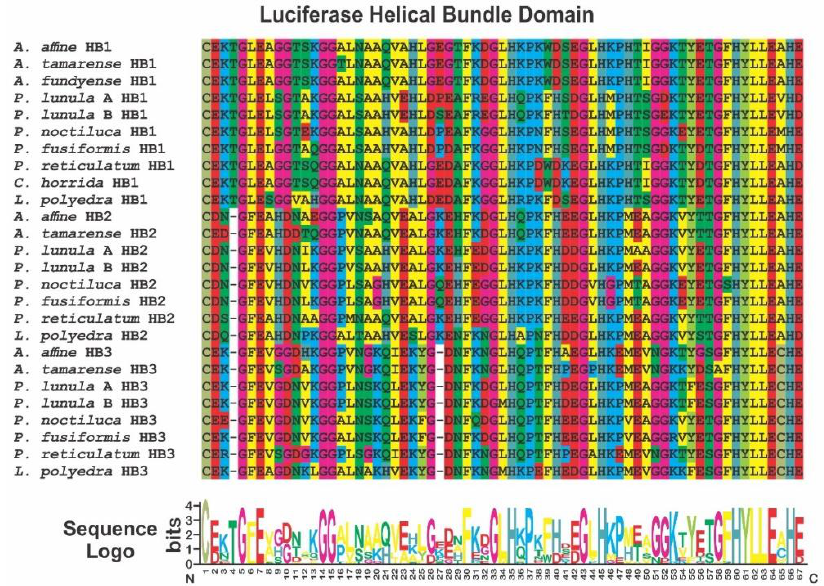
Figure 6. Sequence alignment of the three LCFs helical bundle domains contained in species of the genera Alexandrium , Lingulodinium , Ceratocorys , Pyrocystis and Protoceratium that have their protein published in GenBank. Coloring of the amino acids was made according to the same pattern displayed in MEGA7 software. Sequence logo was made using WebLogo, as described in the